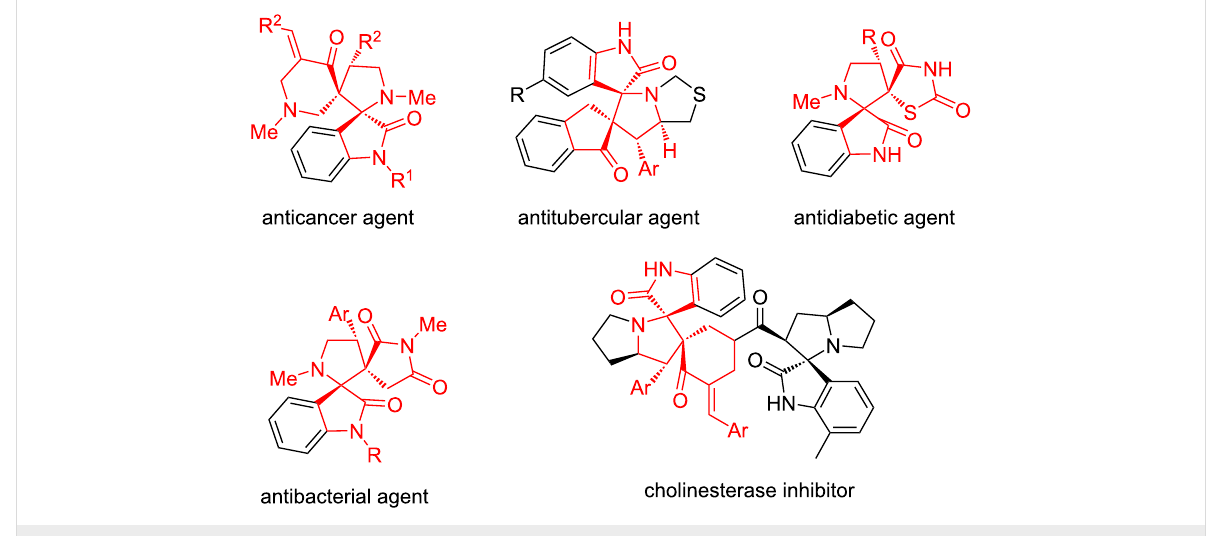
Figure 1: Representative bioactive